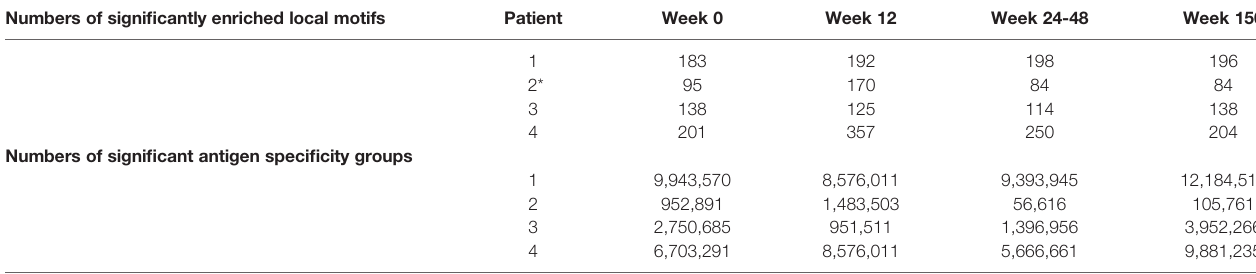
TABLE 3 | TCR clustering characteristics in the memory CD8 + T cell